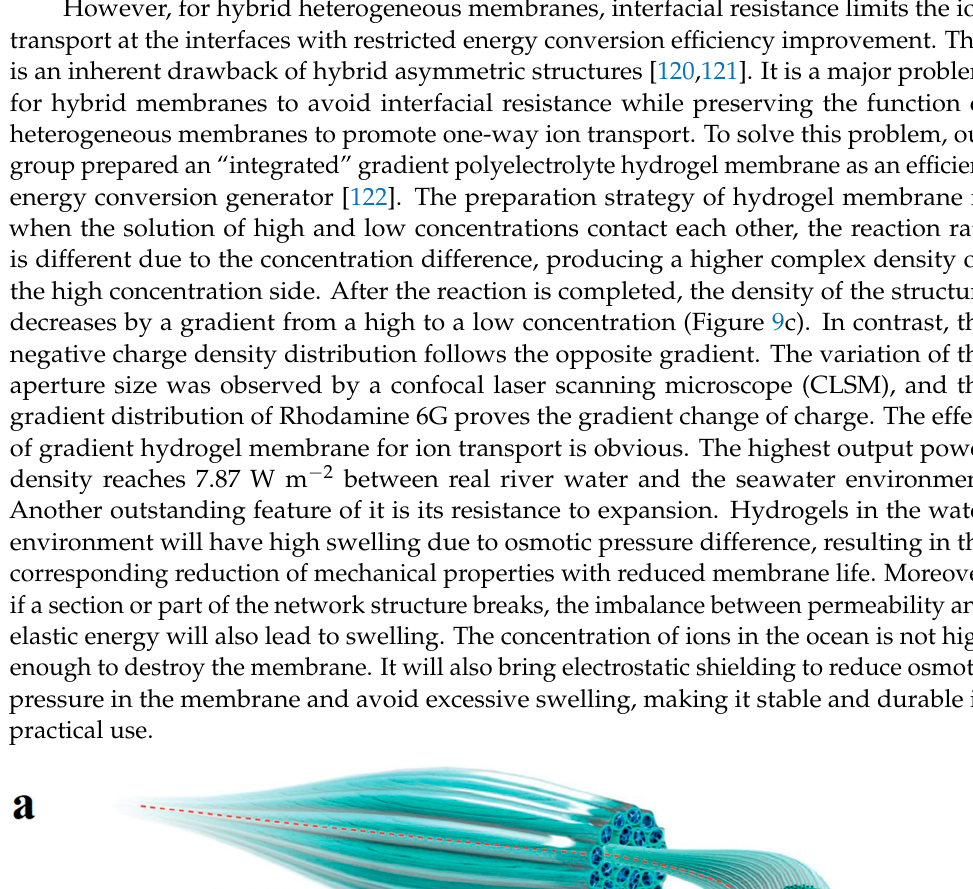
Figure 9. ( a ) Hydrogen bonding between CNF and PAM. Reprinted with permission from Reference [114]. ( b ) Simulation of hydrogel/ANF heterogeneous membrane. Reprinted with permission from Reference [119]. ( c ) Schematic diagram of gradient structure presented by hydrogel membrane. Re- printed with permission from Reference [122]. 5.3. Energy Storage An electrolyte is one of the core components of typical energy storage devices such as batteries and supercapacitors [123]. In addition to meeting the necessary conditions of high ionic conductivity, high chemical stability and safety should be considered in normal working conditions. Although solid and liquid electrolytes are relatively mature and widely used, there are still some inherent defects. For example, liquid electrolytes are flammable and explosive. Solid electrolytes have relatively high internal resistance [124]. Hydrogels are regarded as high-potential electrolyte materials transporting ions and as separators between the poles [125]. The main parameters to measure the performance of electrolytes are ionic conductivity—to achieve efficient ion transport; mechanical strength—good mechanical properties; and flexibility—repeated deformation ability. The high ionic conduction efficiency of hydrogel electrolytes results from its 3D interconnec- tional unique structure and movable path for the ions provided by high water content. However, hydrogel electrolytes used in extreme temperatures are greatly limited by a large amount of water in the hydrogel body. For example, when the temperature drops below 0 °C, water molecules in the hydrogel bind with strong hydrogen bonds, causing the gel to freeze. Improving the freezing resistance of electrolytes starts with lowering the freezing temperature. Hydrogen bond interactions between water molecules can be weak- ened by adding auxiliary materials. Huang et al. added low-concentration zinc ion salt Zn(ClO 4 ) 2 into carboxymethyl chitosan (CMCS) -polyacrylamide (PAM) hydrogel, ClO 4- anion forms ternary interactions with PAM chains and water molecules (Figure 10a),